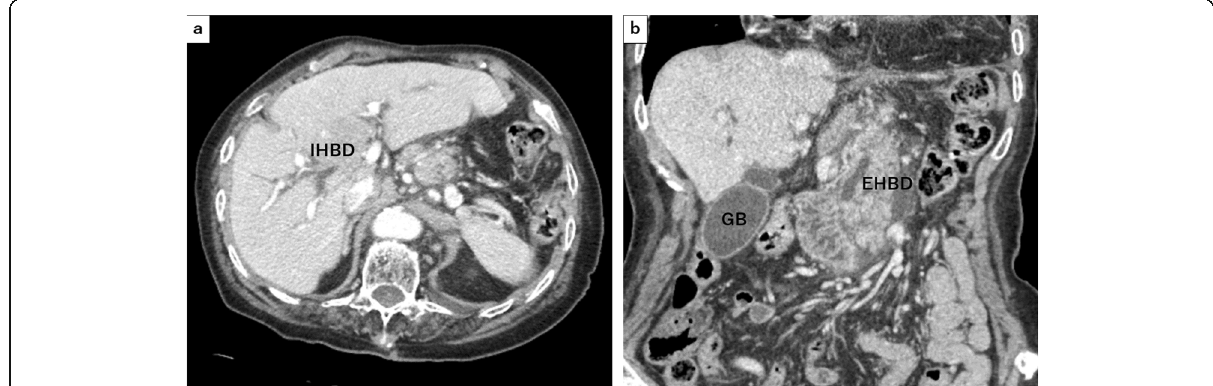
Fig. 3 Enhanced computed tomography (eCT) revealed that the intrahepatic and extrahepatic bile ducts were dilated, and the latter was bended. In axial view ( a ) and in coronal view ( b ). IHDB: intrahepatic bile duct, EHBD: extrahepatic bile duct, GB: